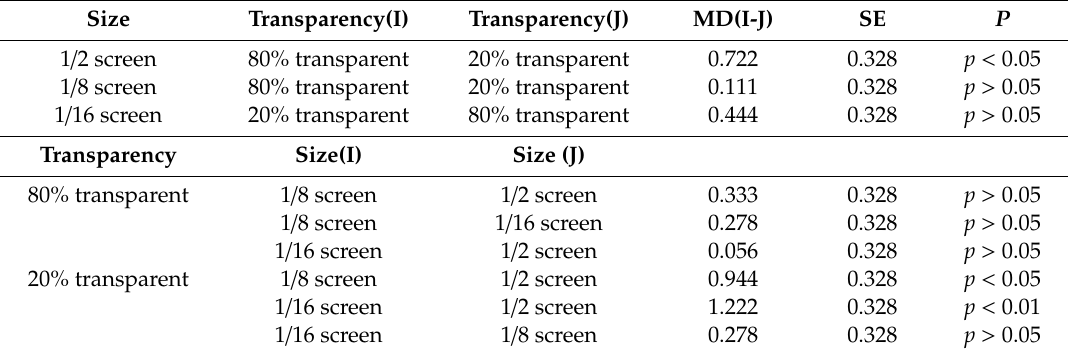
Table 8. Simple e ff ects test for preference. Table 8. Simple effects test for preference.